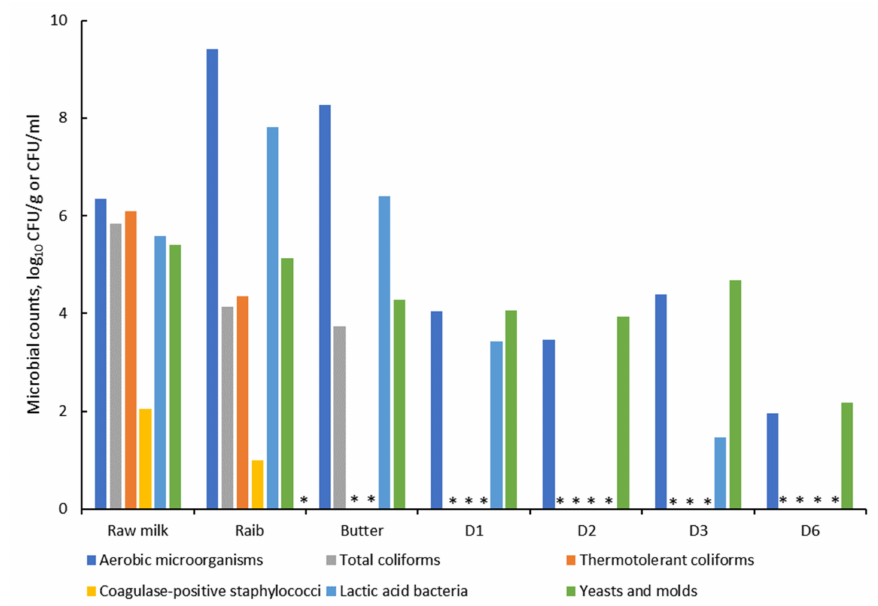
Figure 5. Microbial counts during the different preparation stages of Smen (D1, D2, D3, D6: Smen after one, two, three, and six months of maturation, respectively). * indicates counts below the detection